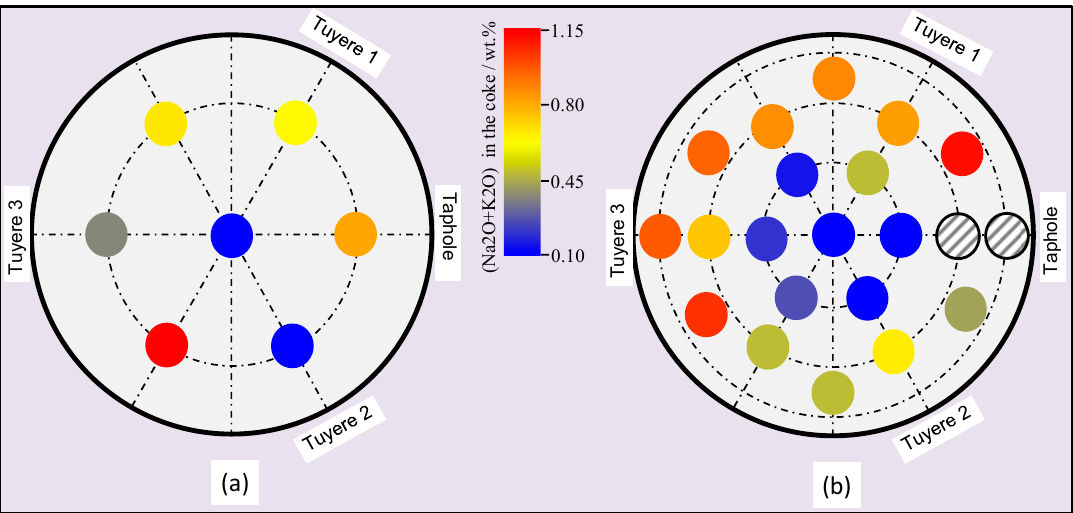
Figure 4. Alkali in the coke samples collected from the EBF hearth: ( a ) first sampling layer; ( b ) second sampling layer. There is no valid data for the samples collected from the close-to-taphole region, due to the involvement of the taphole clay in the samples.